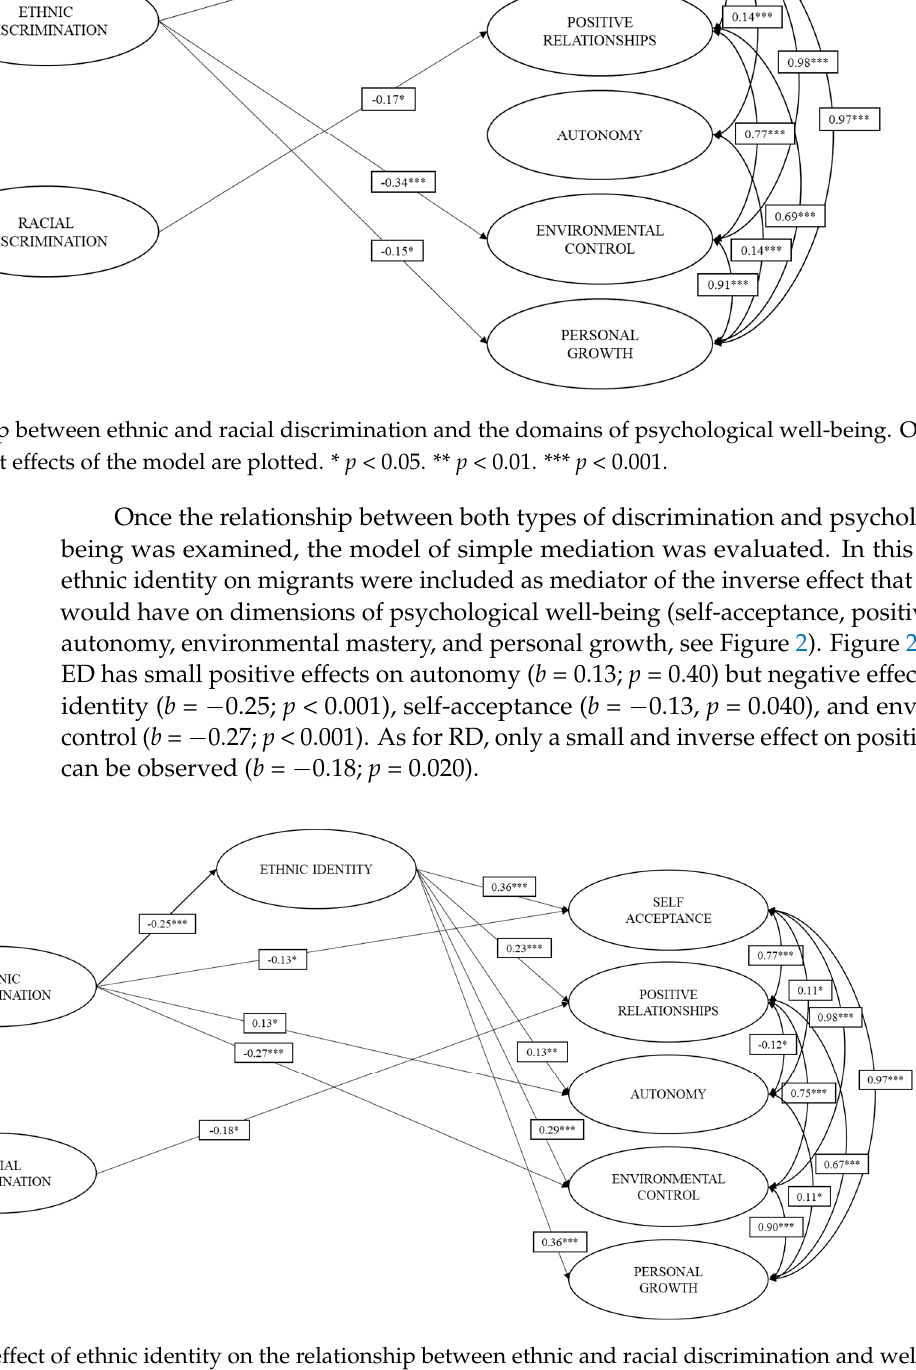
Table 2. Standardized indirect and total effects of the mediation model. Effects